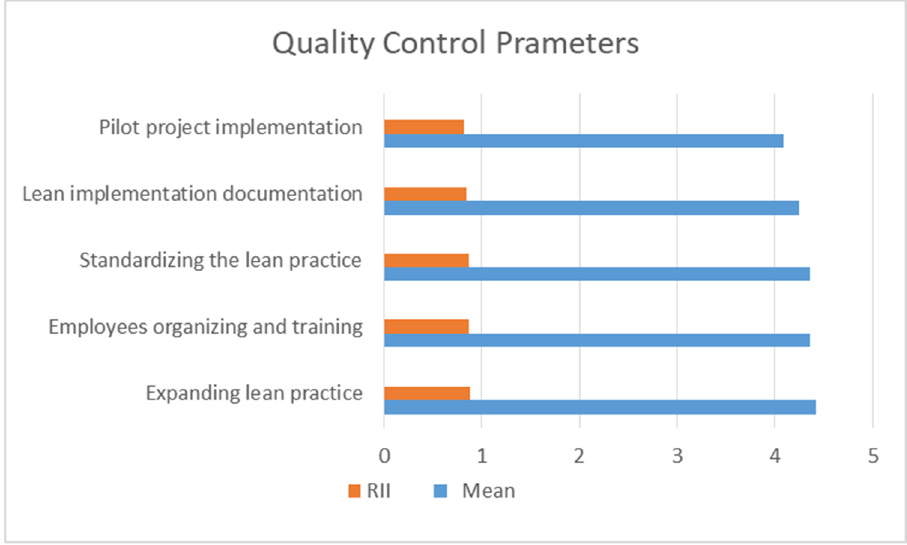
Figure 3. Lean thinking quality control parameters. Legend: RII—Relative Important Index.